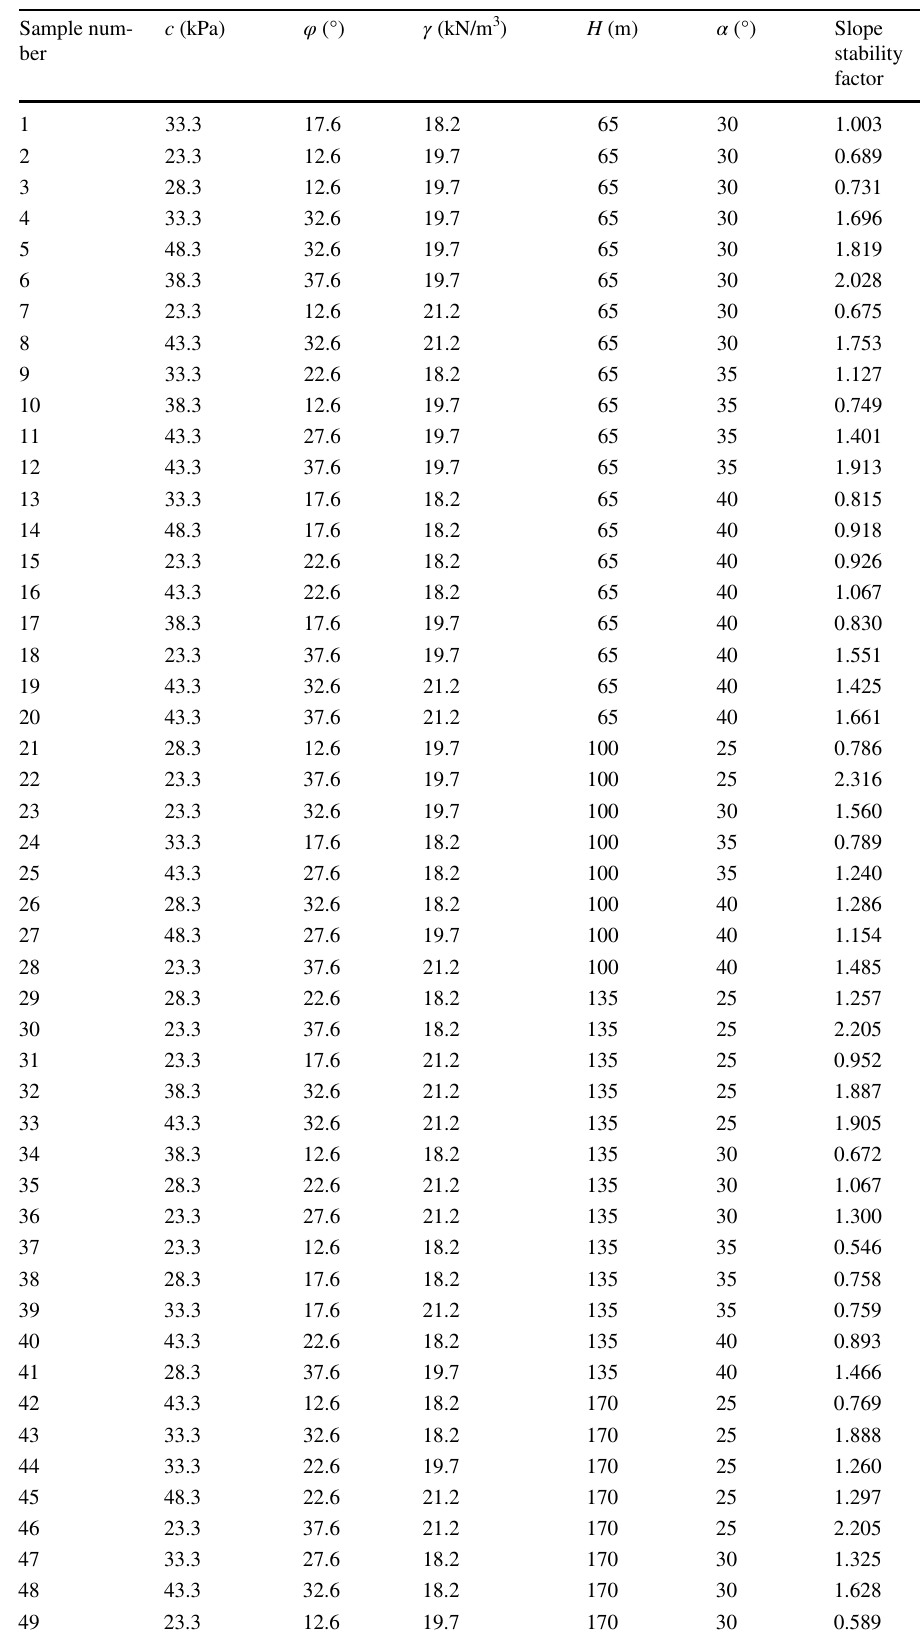
Table 2 Model training data